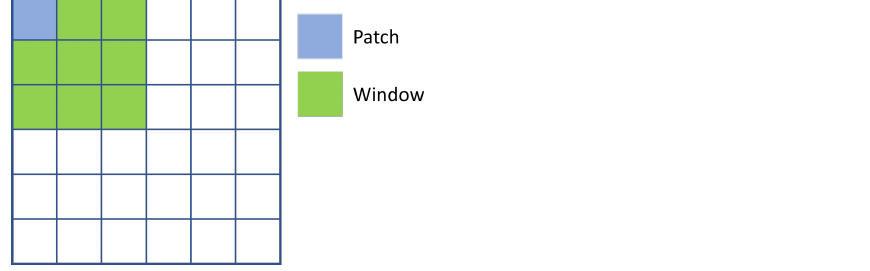
Figure 3. Visualization of the concept of patches and windows in the Swin transformer.